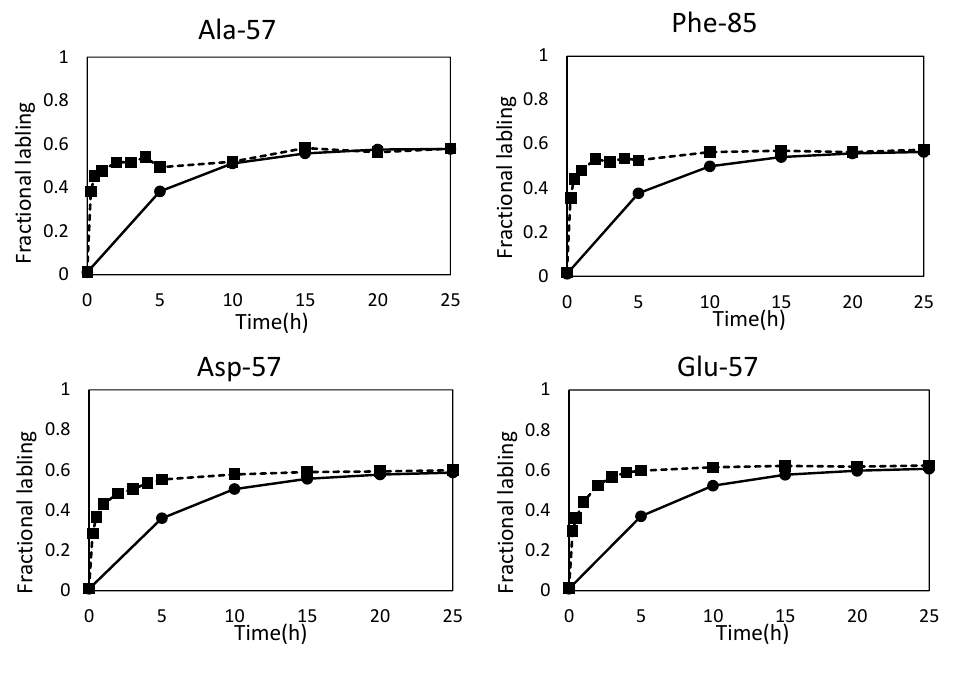
Figure 1. Time course of 13 C enrichment of proteinogenic and free amino acids. Fractional labeling of proteinogenic amino acids (PAAs, Closed circle) and free amino acids (FAAs, Closed square) are represented. Fractional labeling is a ratio of labeled carbons in the metabolite. Other data are shown in Figure